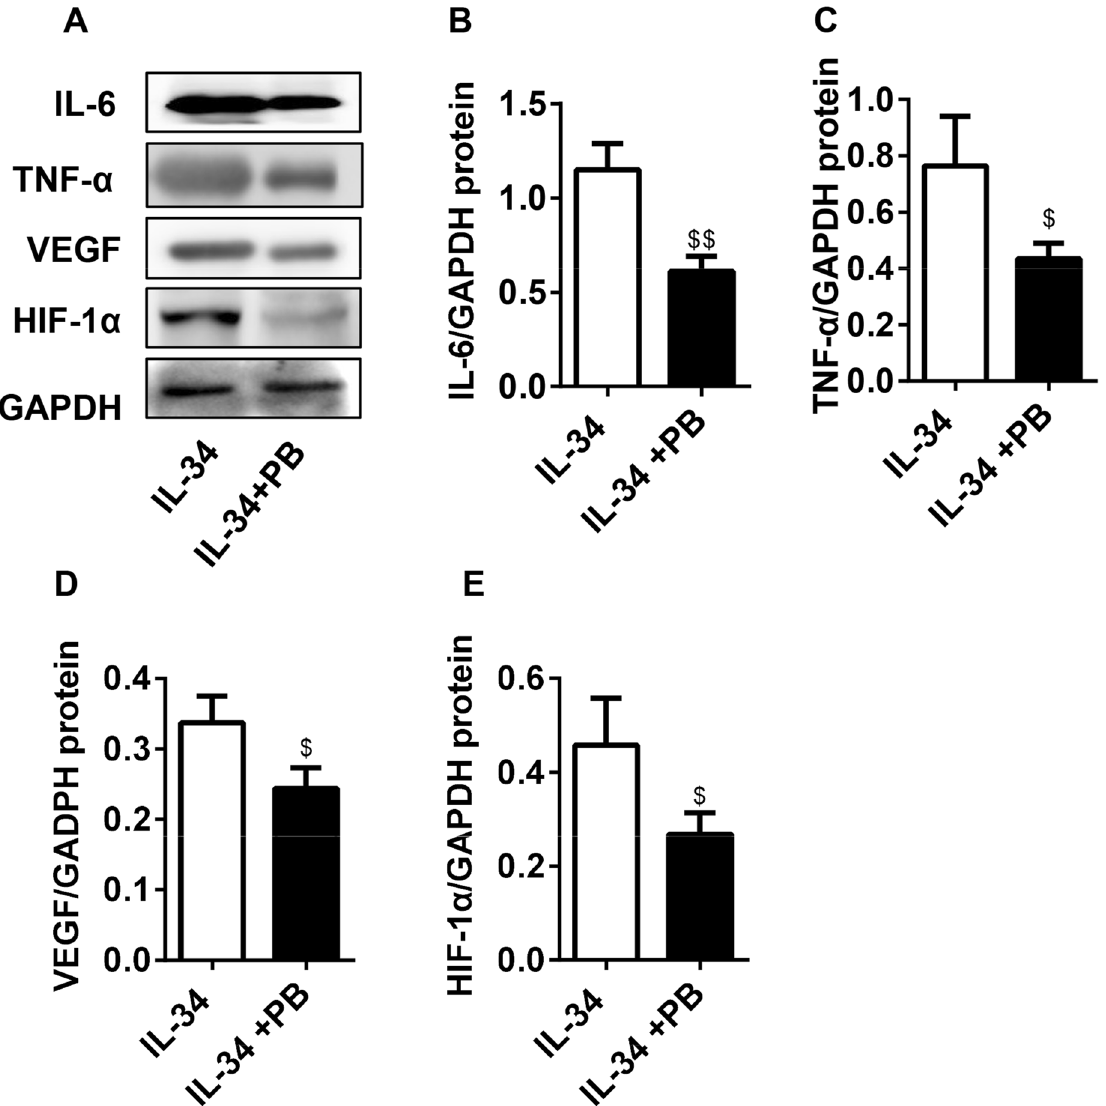
Figure 6. PB antagonized the effect of IL-34 on the protein expression of IL-6, TNF-α, VEGF and HIF-1α in RA-FLSs. ( A ) Western blot images of IL-6,TNF-α,VEGF and HIF-1α protein levels in the IL-34 (100 ng/ml) and IL-34 (100 ng/ml) + PB (4 µM) treatment groups. ( B–E ) The protein levels of IL-6, TNF-α, VEGF and HIF-1α in RA-FLSs treated with IL-34 (100 ng/ml) or IL-34 (100 ng/ml) + PB (4 µM) were analyzed by Western blotting. The differences between two groups were tested by two-tailed Student’s t-tests. The data are expressed as the mean ± SEM. $ P < 0.05, $$ P < 0.01 vs the IL-34